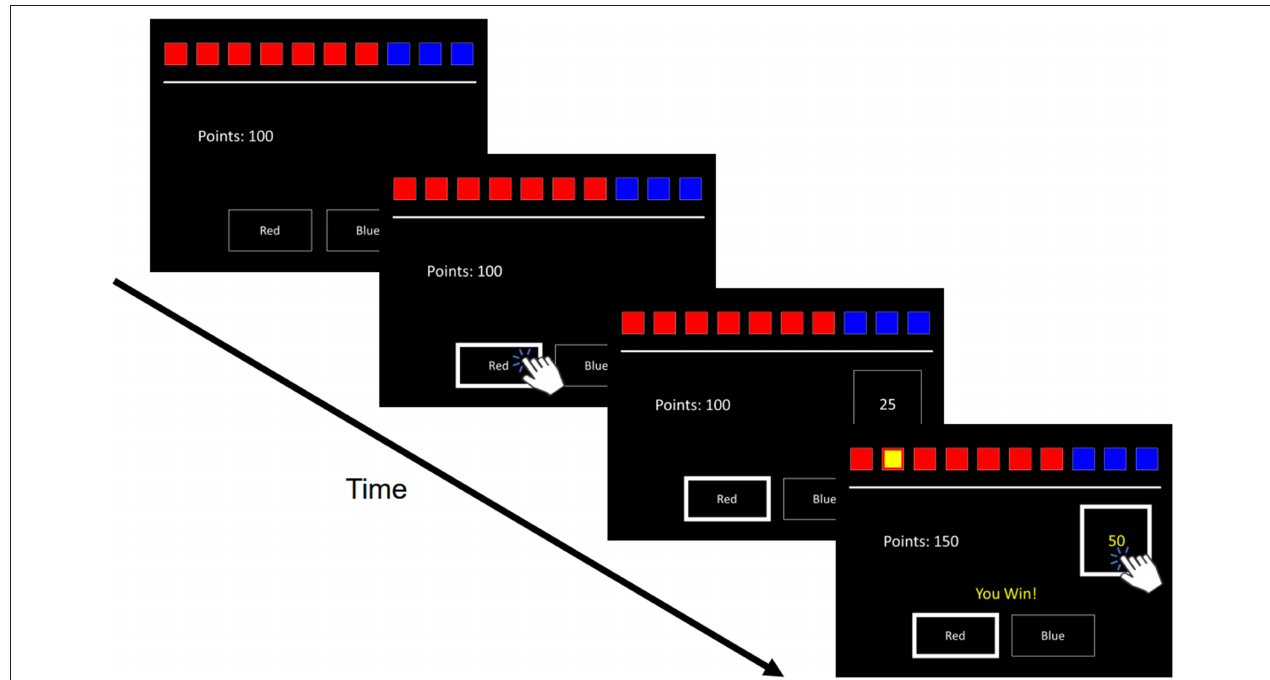
FIGURE 1 | Trial Schematic of the Cambridge Gambling Task. Ten boxes are displayed varying in proportions of red to blue. Respondents guess which color hides a yellow token. Participants are then prompted to select a bet, with bet amounts appearing in either ascending or descending order. If respondents guess correctly or incorrectly, the selected bet amount is either added or subtracted to their total